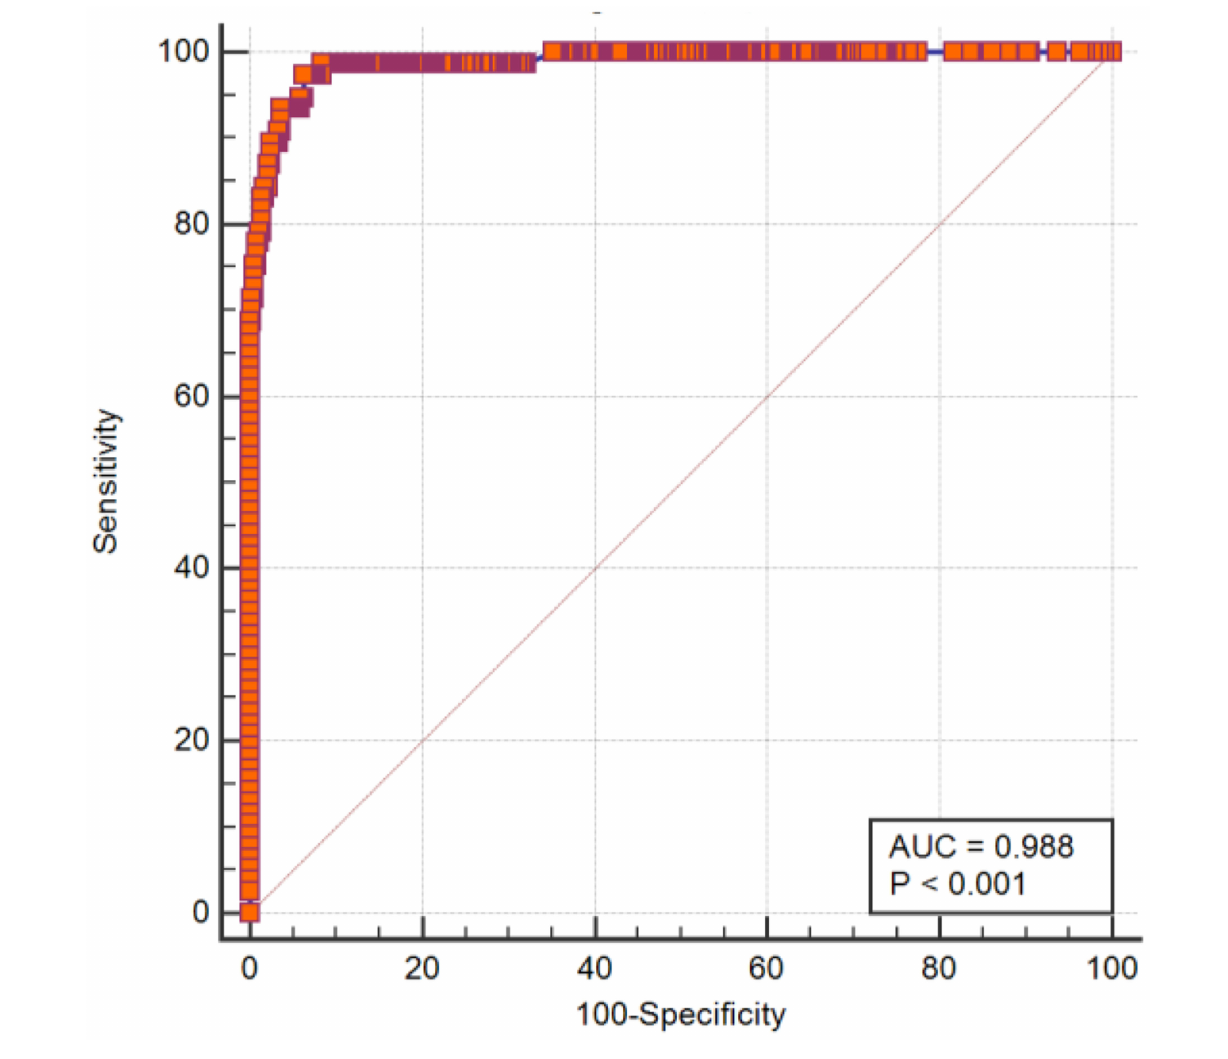
Cerebral perfusion is dependent on cardiac